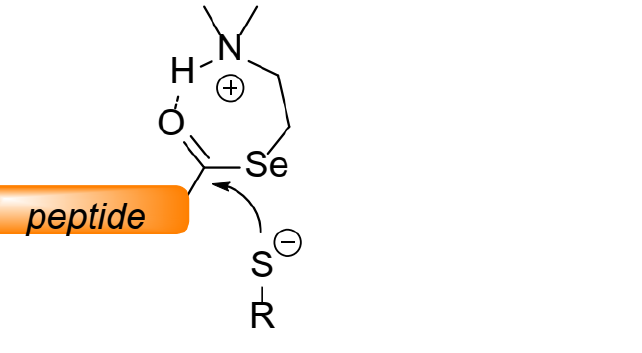
Figure 5. The presence of a protonated amine nearby the peptide carbonyl might promote the attack of thiol